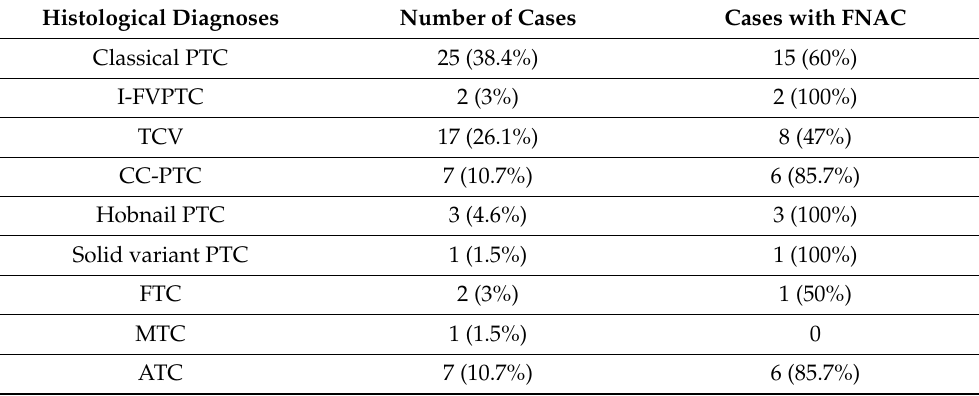
Table 2. Histological diagnoses with pre-operative cytological diagnoses. Histological Diagnoses Number of Cases Cases with